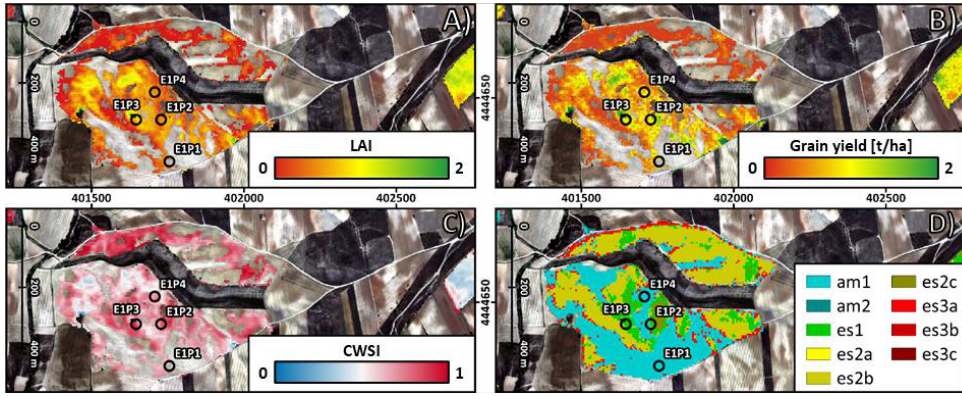
Figure 10. Field plot E1: Spatial distribution of estimated ( A ) LAI and ( B ) Grain yield; ( C ) CWSI compared with ( D ) Bare soil classification of SEAS of Schmid et al. (2015).